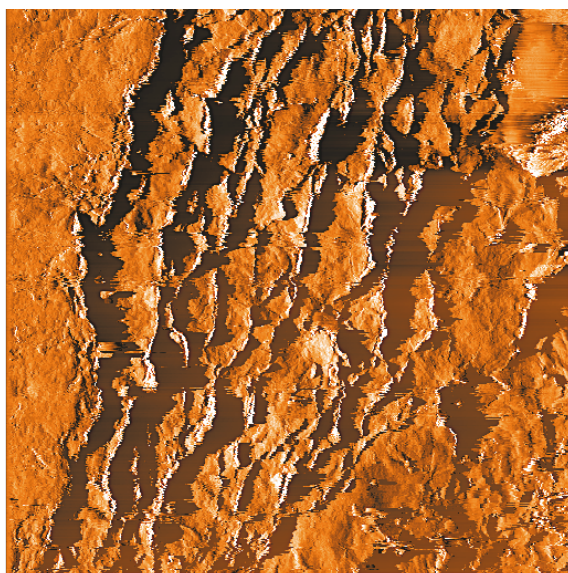
Figure 11: This image, taken with the SHOCON contact probe, clearly depicts the stratified nature of the graphene oxide sample. The scale length is 40 𝜇 m by 40 𝜇 m and the sample underwent 4 reduction cycles with the